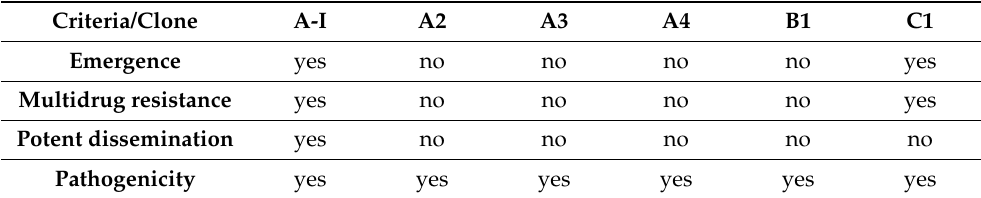
Table 3. Revised criteria for high risk clone applied to the clones identifies in our study. Criteria/Clone A-I